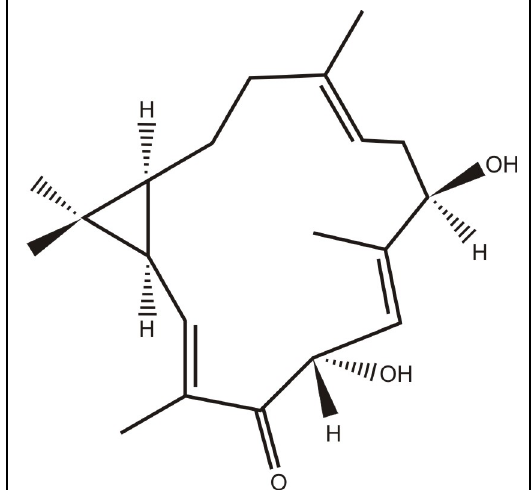
Figure 3. Structure of casbane diterpene extracted from the stalks of Croton